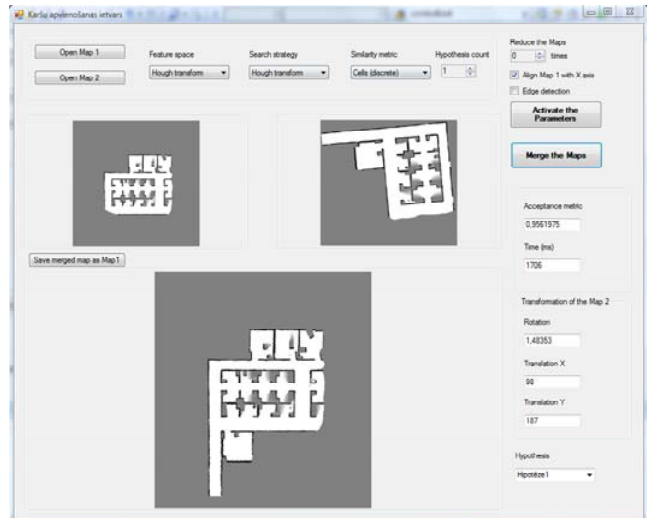
Fig. 1. An example of successful map merging with the framework developed by the author